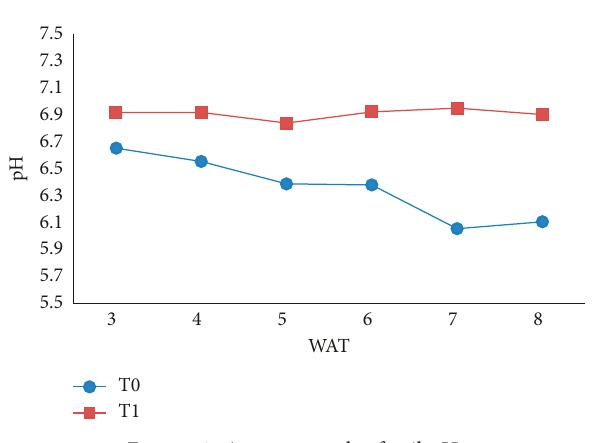
Figure 2: Average graph of soil pH.